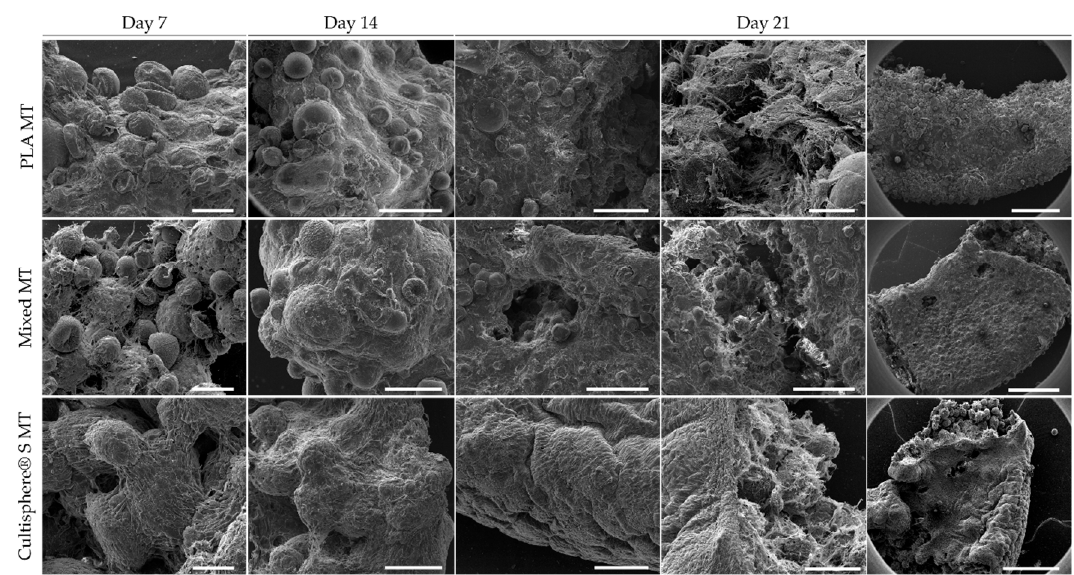
Figure 5. Cell-derived matrix (CDM) deposition assessment through SEM microscopy, scale bars = 100 μ m (Day 7), 200 μ m (day 14), 50–1000 μ m (day 21).